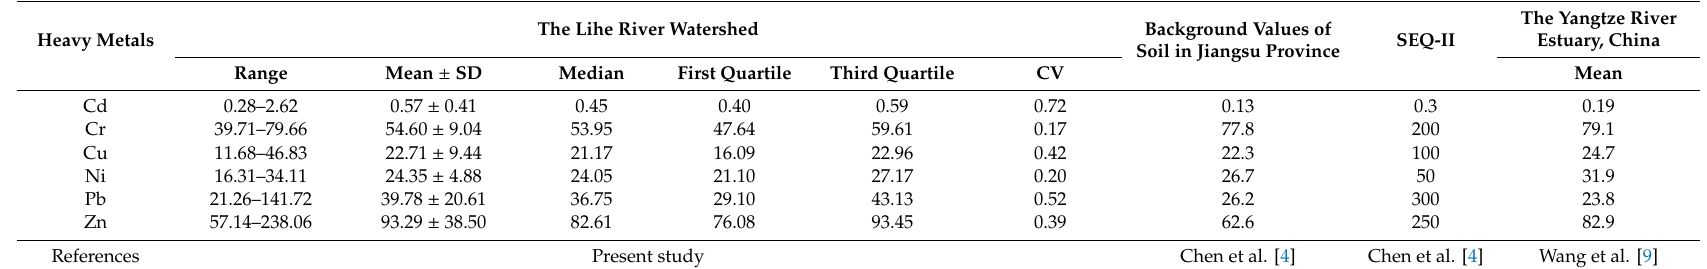
Table 4. Total heavy metal concentrations in soil from the Lihe River Watershed and other selected areas for comparison (unit mg kg –1